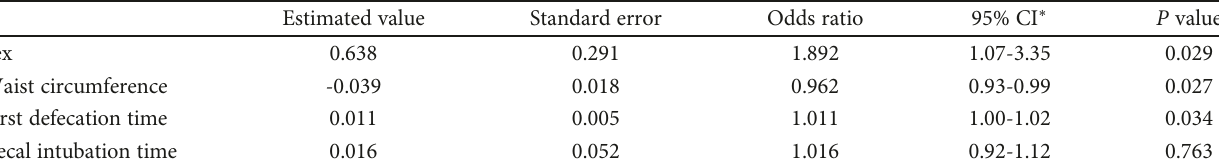
Table 2: Independent factors associated with inadequate preparation of the proximal colon on multivariate